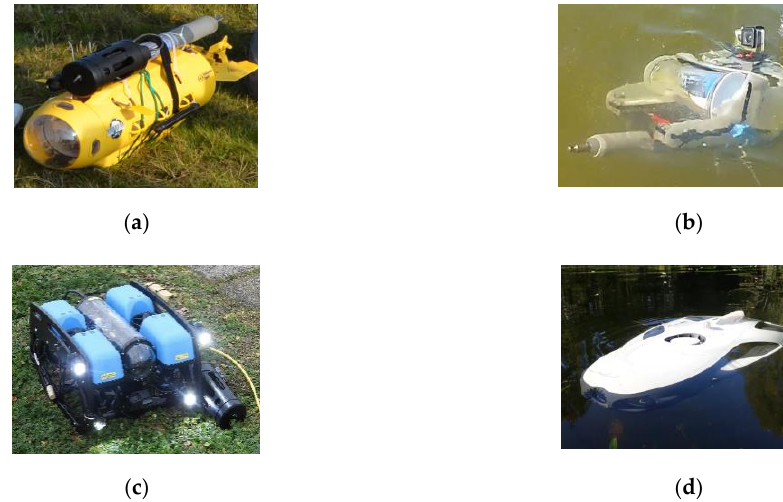
Figure 1. Illustration of multiple underwater drones equipped with cameras, lights, or water quality sensors. ( a ) Neptune; ( b ) OpenROV 2.7; ( c ) BlueROV2; ( d ) PowerRay.